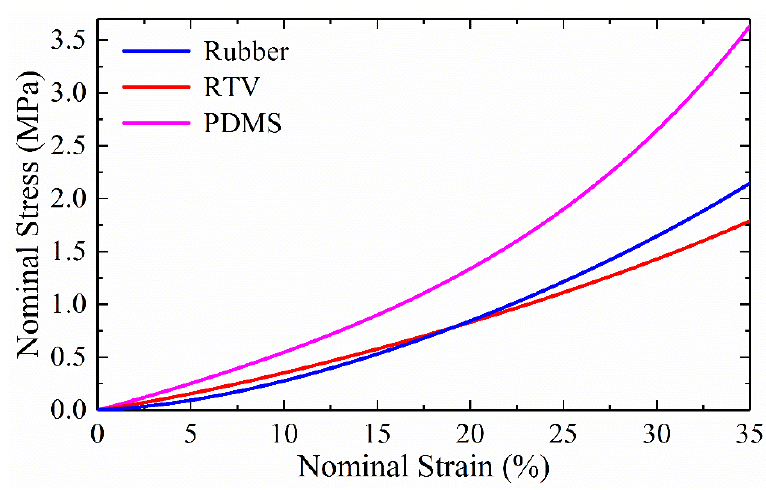
Figure 3. Measured nominal stress versus strain curves of rubber, room temperature vulcanizable (RTV) and polydimethylsiloxane (PDMS) materials.